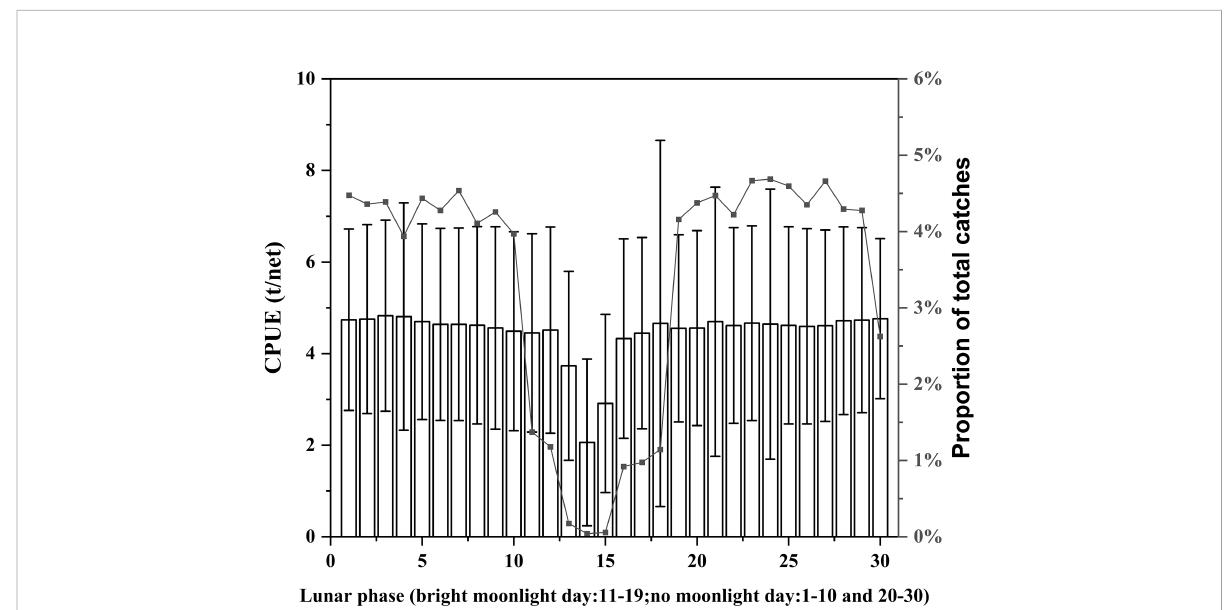
FIGURE 5 Variation in the proportion of total catches (line) and CPUE (bar) of light falling gear in the Northwestern Indian Ocean on the lunar phase scale (mean ± standard